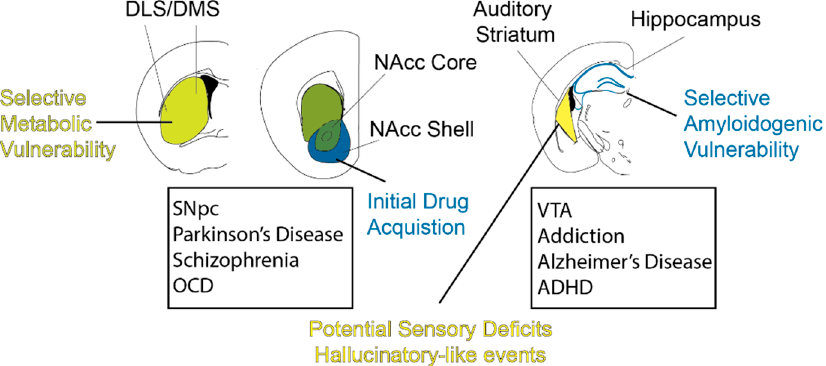
Figure 2. Summary of reviewed DA-related diseases categorized according to different brain re- gions. Diseases associated with the SNpc include, but are not limited to, Parkison’s, schizophrenia, and OCD. The DLS is subject to metabolic and molecular vulnerability in Parkinson’s disease. The tail striatum has recently been implicated in hallucinatory-like percepts in schizophrenia models. Diseases associated with the VTA include, but are not limited to, addiction, Alzheimer’s disease, and ADHD. The shell of the nucleus accumbens have specifically been linked to hedonic processing and plasticity in initial drug acquisition. The VTA also projects to the hippocampus and it has been found that these neurons are vulnerable in amyloidogenic mouse models.